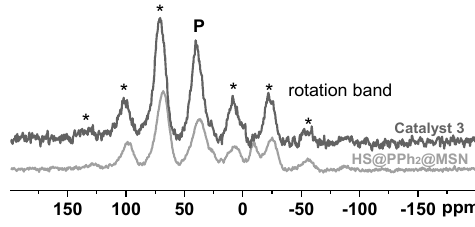
Figure 2. The solid-state 29 Si MAS NMR spectrum of catalyst 3 .